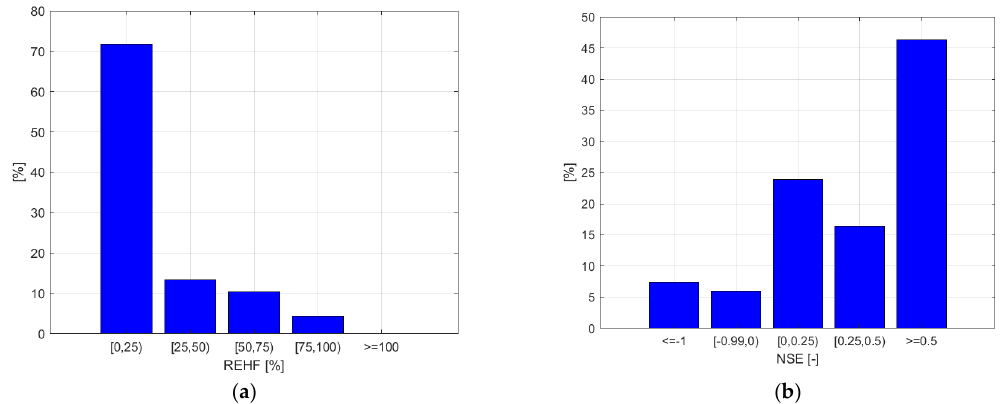
Figure 14. Frequency histograms of REHF ( a ) and Nash–Sutcliffe ( b ), considering only the calibrated sections.